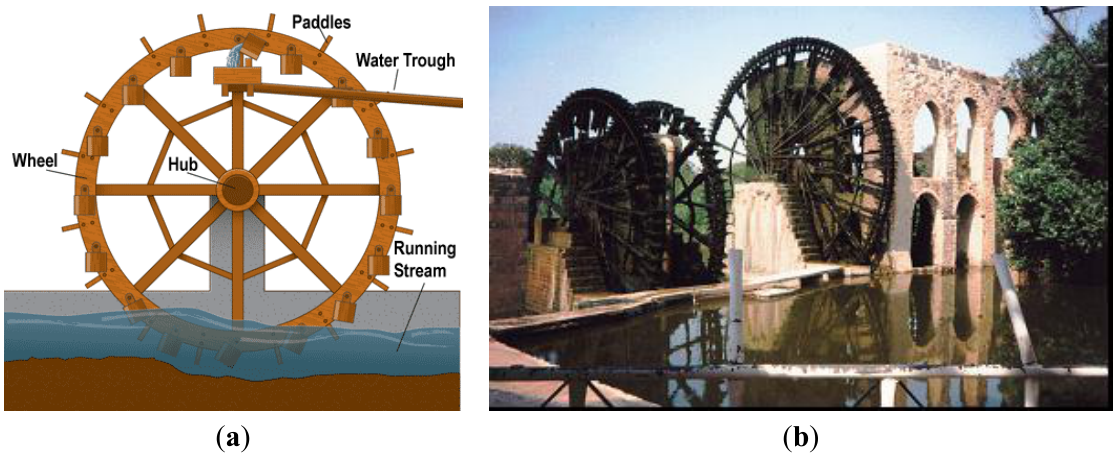
Figure 2. Waterwheel (Noria): ( a ) parts; and ( b ) in Hama on Orontes River in Syria (adapted from